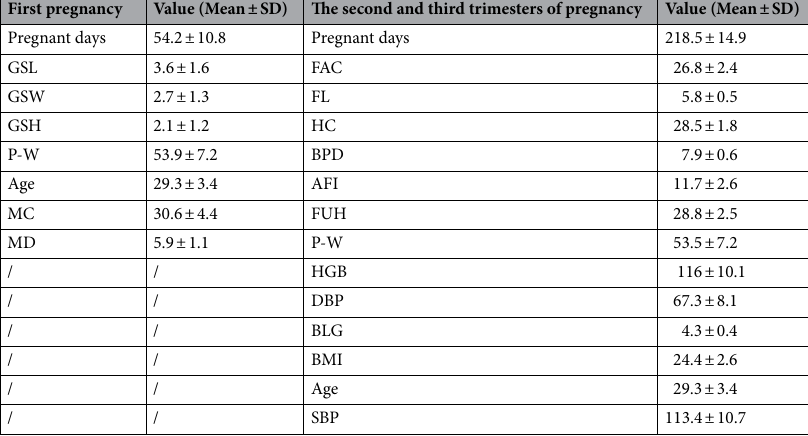
Table 3. Summary statistics of parameters.